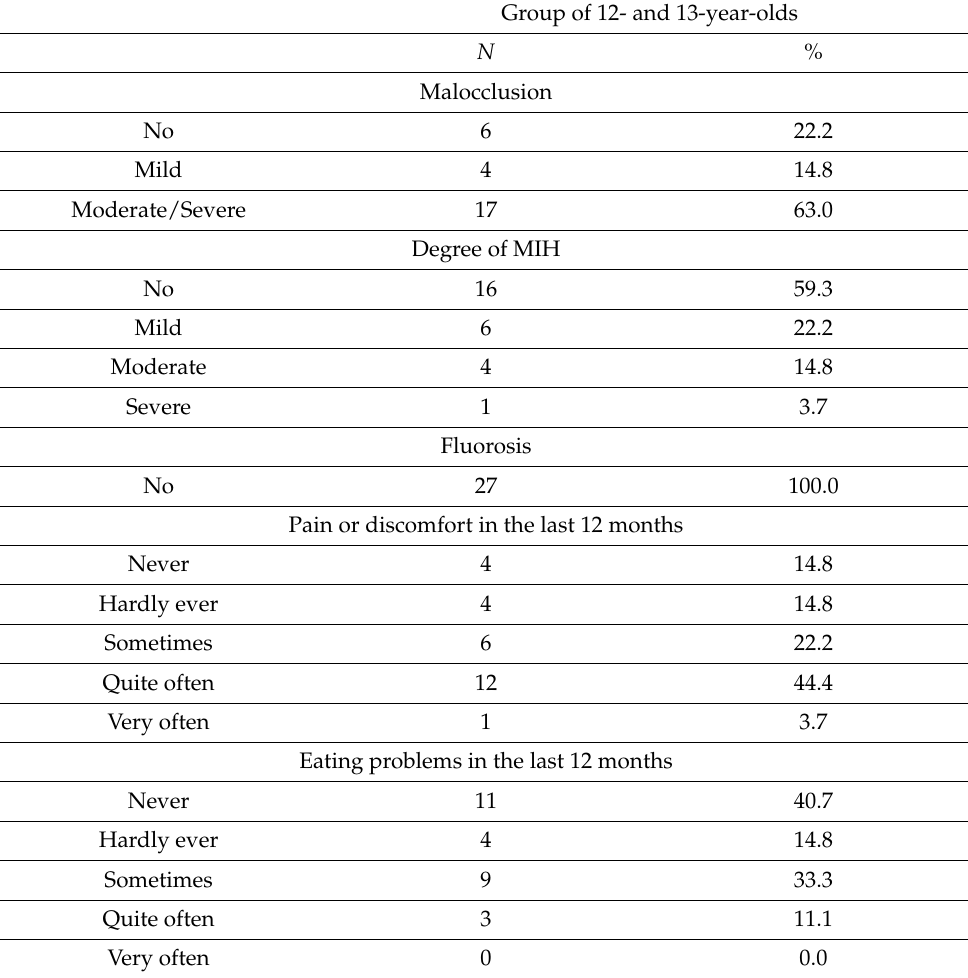
Table 4. Description of clinical and subjective variables for the 12- and 13-year-old age group.